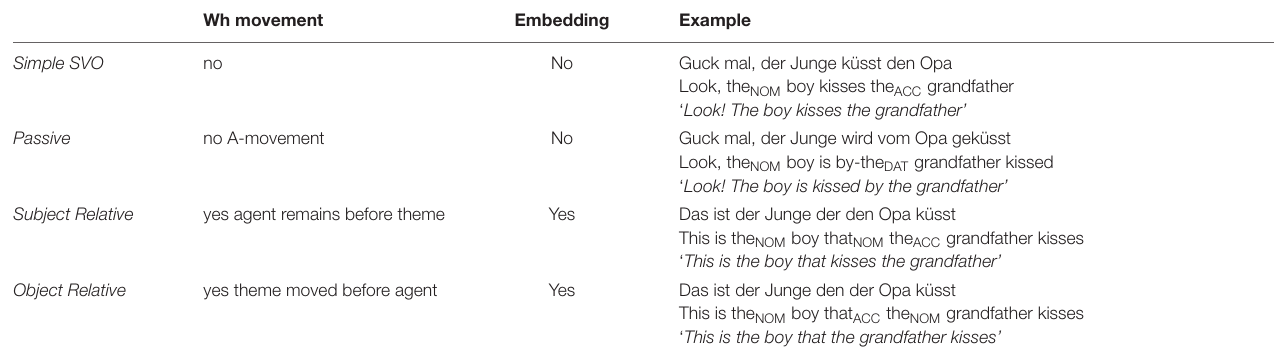
TABLE 1 | Types of sentences in Experiment